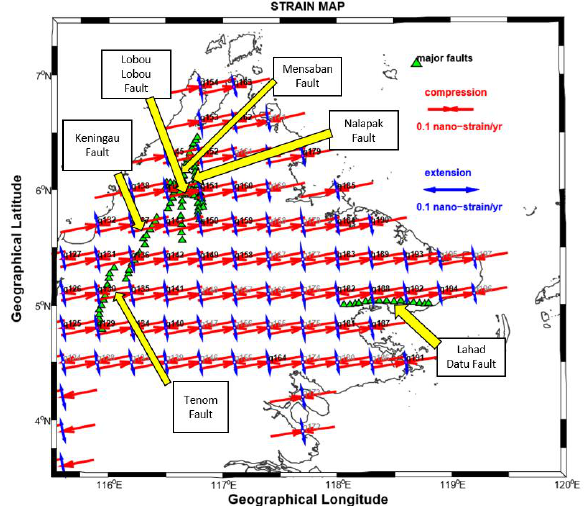
Figure 15. Strain rate map over Sarawak in 2007.